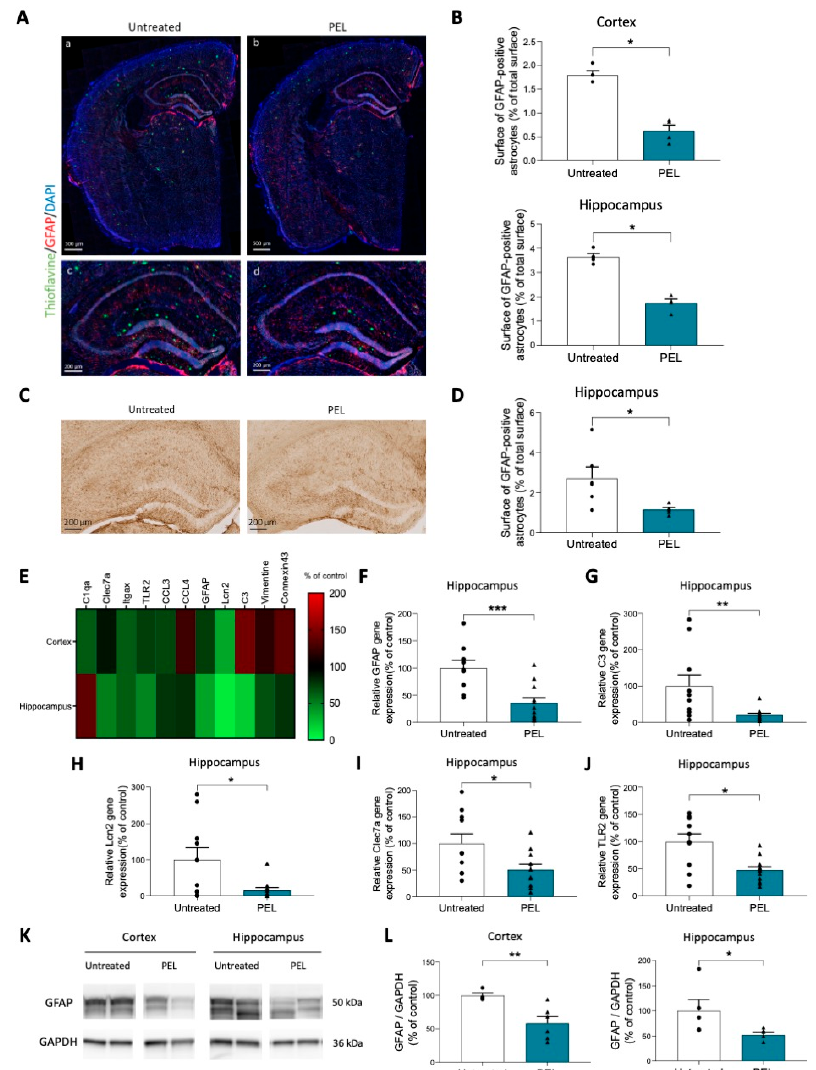
Figure 3. Astrogliosis and inflammation are decreased by PEL24-199 treatment. ( A ) Representative images of the cortex and hippocampus staining for the Thioflavin-S (green), DAPI (blue), and the reactive astrocyte marker GFAP (red). Upper panels: scale bar = 500 µm; Lower panels: scale bar = 200 µm. ( B ) The percentage of a total surface of GFAP-positive astrocytes was investigated in the cortex and hippocampus of APP/PS1 mice treated or not with PEL24-199. Both in the cortex and hippocampus, the surface of GFAP-positive astrocytes was significantly decreased (n = 4 per group). ( C ) Representative images of GFAP immunostaining in the hippocampus of twelve months-old APP/PS1 treated with water or PEL24-199. Scale bar = 200 µm. ( D ) The surface of GFAP-positive astrocytes was significantly decreased in the hippocampus of PEL24-199 treated animals compared to untreated APP/PS1 animals (n = 5–6 per group). ( E ) Heat-map of activated astrocytes and microglia genes in the cortex and hippocampus of PEL24-199-treated APP/PS1 mice expressed as a percentage of control untreated APP/PS1 (red: increased expression; green: decreased expression). ( F – J ) Relative GFAP, C3, Lcn2, Clec7a, and TLR2 gene expression in the hippocampus of APP/PS1 mice treated with PEL24-199 is expressed as a percentage of untreated APP/PS1 (n = 9–13 per group). ( K ) Western blot analysis of GFAP was performed in the cortex and hippocampus of water and PEL24-199 treated APP/PS1 mice. ( L ) . Histograms representing GFAP protein levels in the cortex and hippocampus of PEL24-199 treated and untreated APP/PS1 mice (n = 4–6 per group). Significance at the Mann-Whitney statistical test is indicated by *: p < 0.05, ** p < 0.001, *** p <